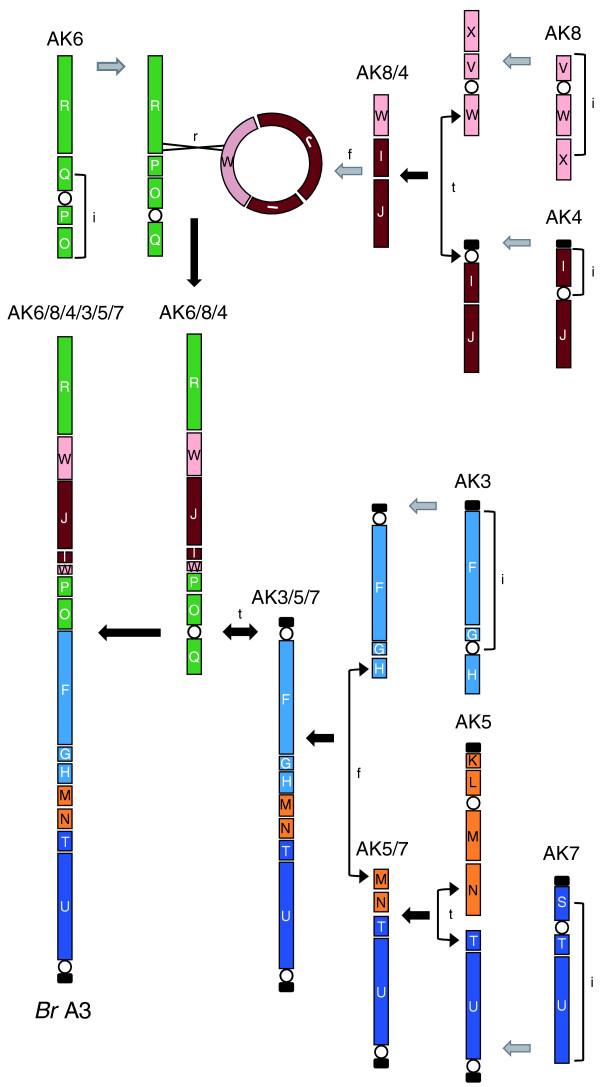
Hypothetical derivation of chromosome A3. Chromosome A3 has originated due to inversion (i), translocation (t), fusion (f), and recombination (r) of six AK chromosomes (AK3, AK4, AK5, AK6, AK7, and AK8). The ancestral chromosomes are presumed to bear NORs (black rectangles) and centromeres are represented as empty spheres. The minichromosomes consisting of a NOR and a centromere that resulted from translocation events have presumably been lost.